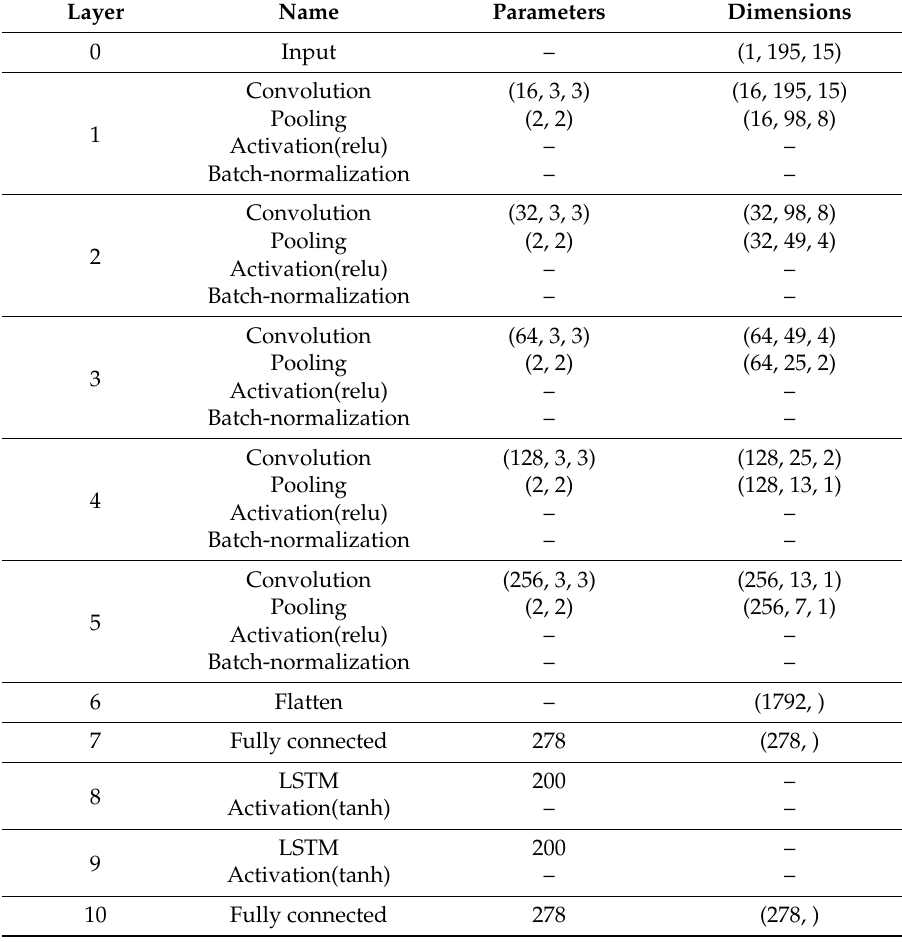
Table 2. Hyperparameters of the hybrid convolutional long short-term memory neural network model based on critical road sections (CRS-ConvLSTM) when α =